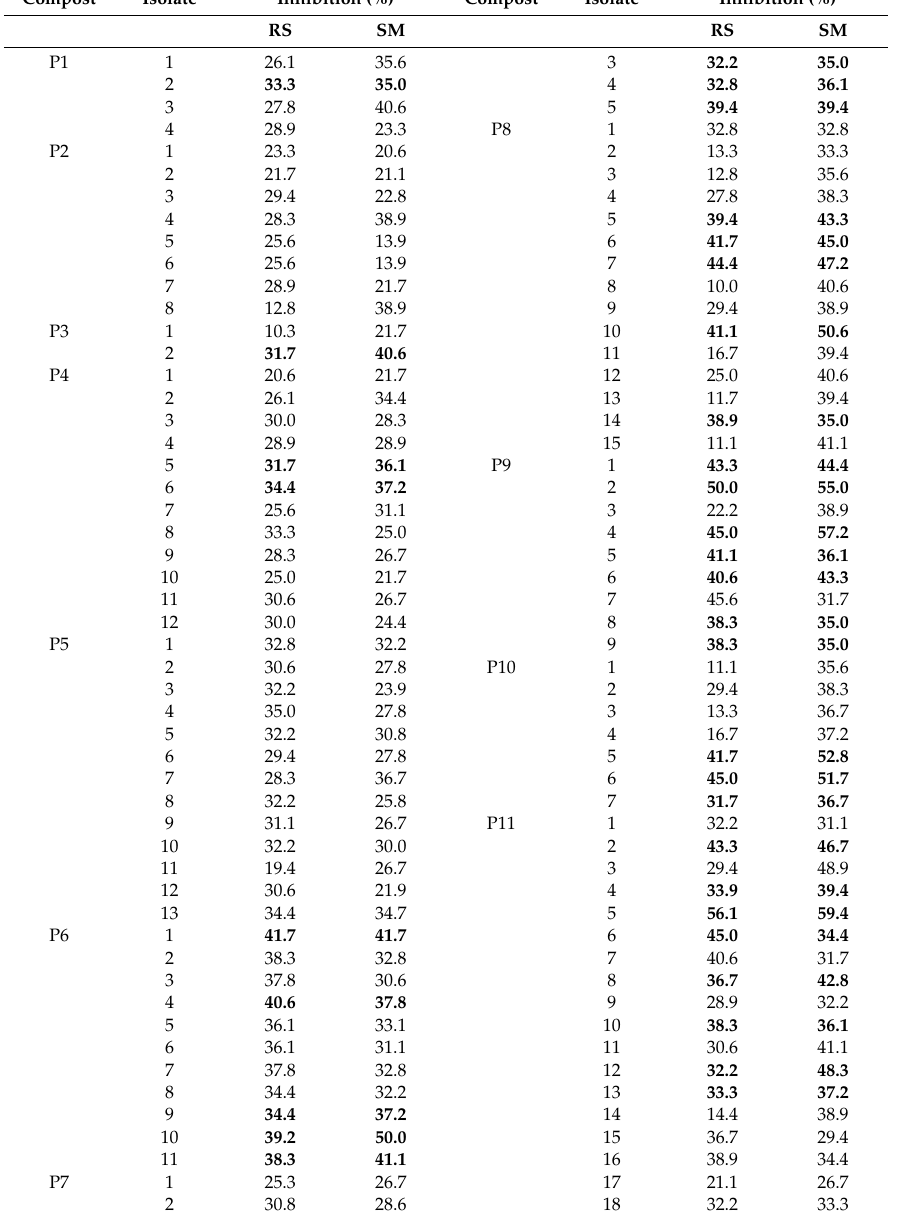
Table 3. In vitro inhibition percentage of Sclerotinia minor and Rhizoctonia solani mycelial growth in a dual culture assay of the 104 isolates obtained from the composts (P1–11), against the target pathogens. In bold are indicated the 35 isolates chosen for showing a growth inhibition above the average of all the